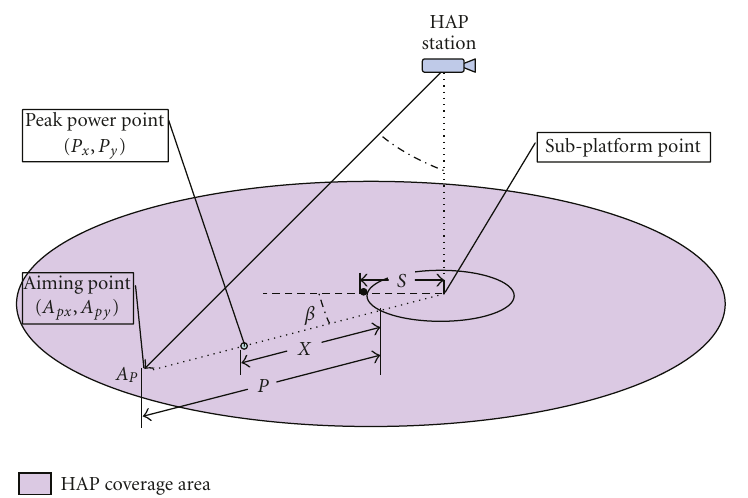
Figure 3: Peak receiving point and aiming point from di ff erent directional antennas of a single HAP.